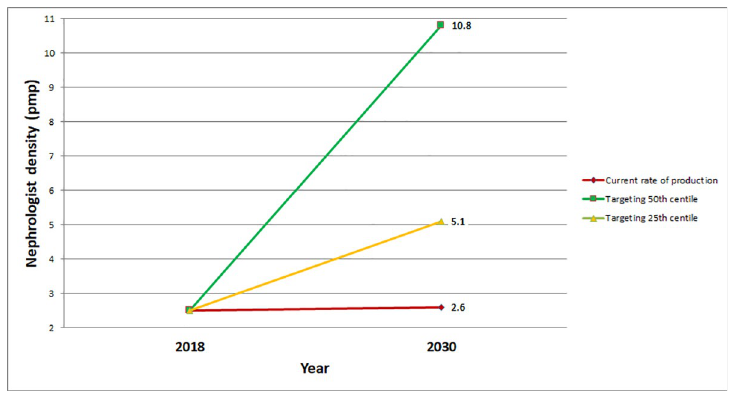
Fig 3. Benchmarking South African nephrologist density against upper-middle-income country targets. Based on the 50 th and 25 th centile densities from the Global Kidney Health Atlas [1]. Abbreviation: pmp, per million population.